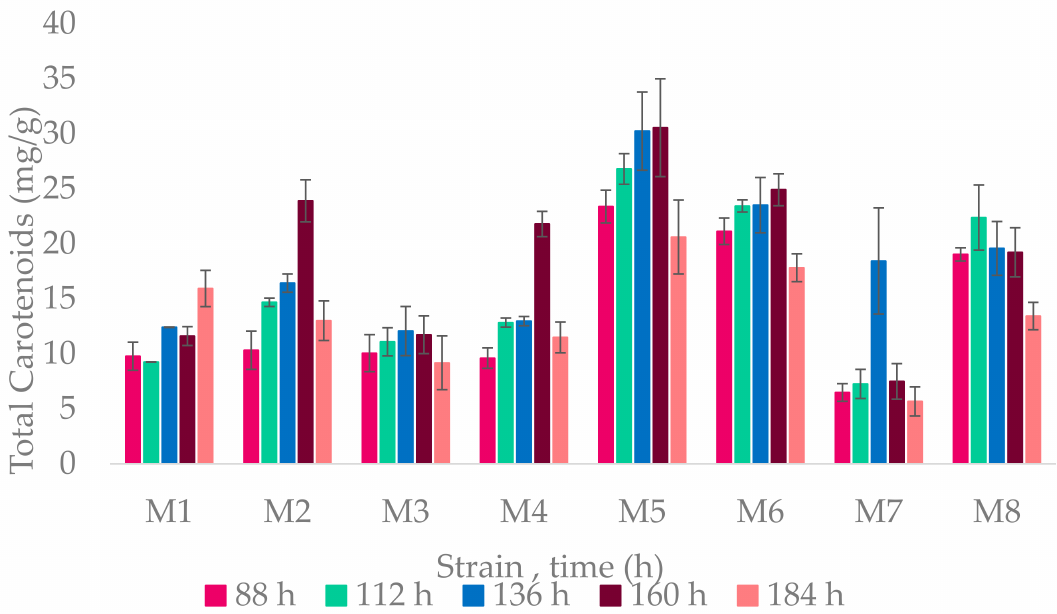
Figure 5. Yield of pigments produced per gram of dry weight biomass. On the X axis, the time in hours and the strain code; on the Y axis, the total yield of carotenoids expressed in